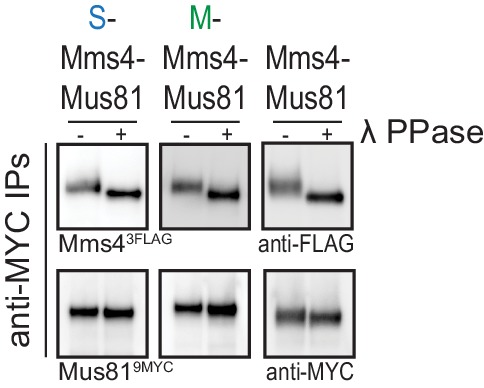
λ-Phosphatase treatment leads to efficient Mms4 dephosphorylation of WT, S- and M-Mus81-Mms4 used for activity assays.Western blot analysis of Mms4 shows efficient dephosphorylation of Mms4 after λ-Phosphatase treatment of WT, S- and M-Mus81-Mms4 preparations used in activity assays (see Figure 2D for activity assay done with S-, M- and WT Mus81-Mms4).